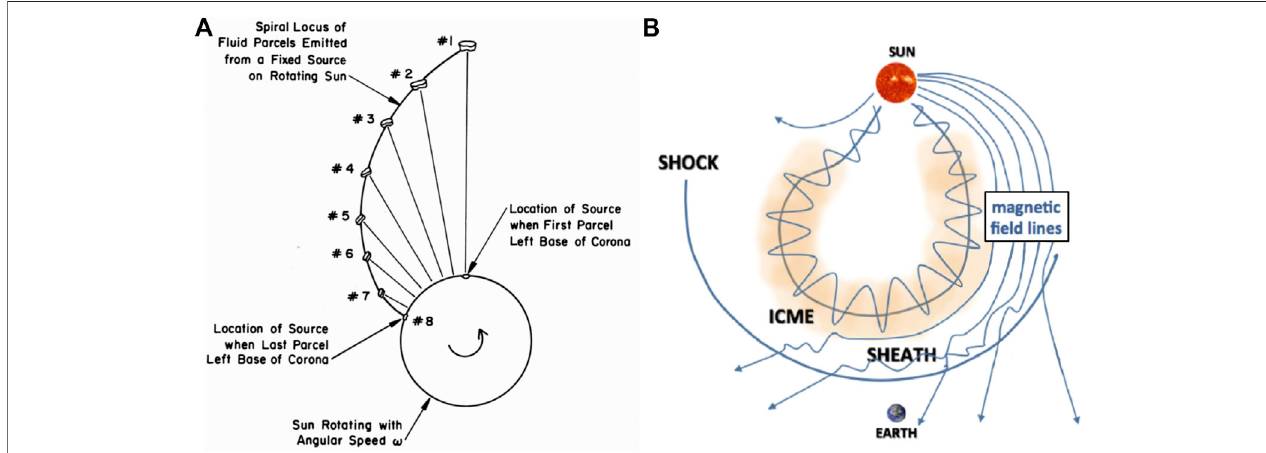
FIGURE 8 | (A) Depiction from Russell et al. (2016) of the formation of the Parker spiral by the Sun ’ s rotation causing parcels of radially emitted plasma to be released from the Sun at differing locations because of the ever-changing orientation of the emission region on the Sun ’ s surface. (B) Diagram of an ICME as it moves through interplanetary space (Kilpua et al., 2017). This image was distributed under the https://creativecommons.org/licenses/by/4.0/legalcode Creative Commons Attribution 2.0 International License. Note the spiral magnetic fi eld lines created because of the Parker spiral pattern explained in (A)